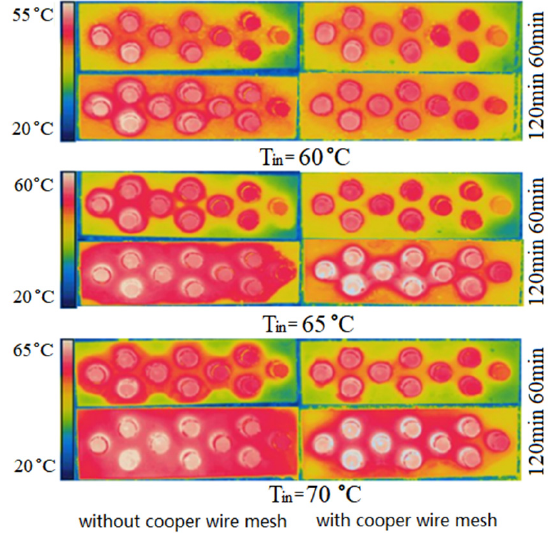
Figure 10. Experimental photos of temperature fields on PCM-1 upper surface.